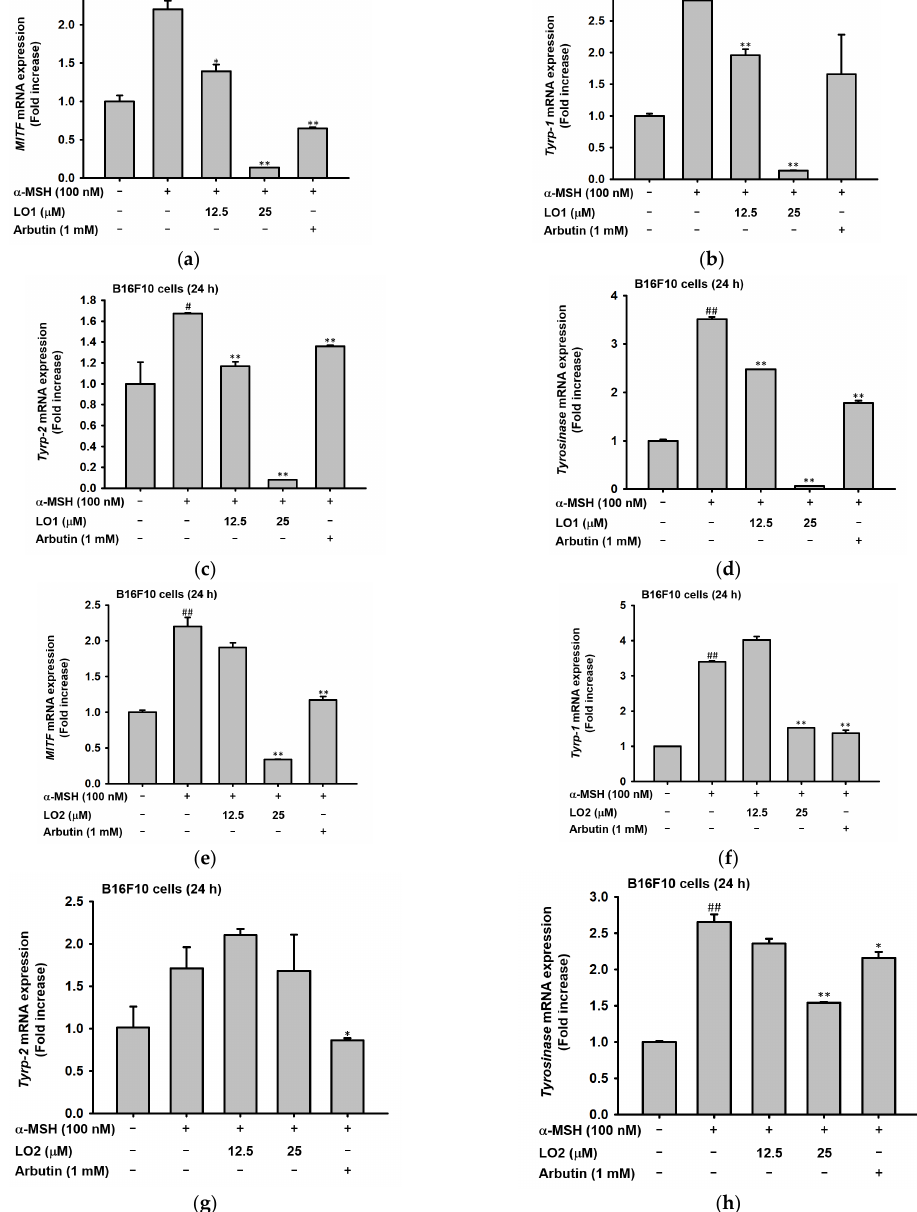
Figure 5. Real-time PCR was conducted to measure mRNA expression after α -MSH treatment ac- companied by LO1 and LO2 treatment for 24 h in B16F10 melanoma cells. Expression of MITF mRNA level in LO1-treated condition in B16F10 melanoma cells. ( a ) The mRNA level of TYRP-1 with or without α -MSH. ( b ) The TYRP-2 expression at the transcription level when treated with LO1. ( c ) Tyrosinase expression was detected in a Real-time PCR assay in treating LO1. ( d ) MITF mRNA level when LO2 treated in B16F10 melanoma cells. ( e ) The expression level of TYRP-1 at the mRNA level. ( f ) The mRNA expression of TYRP-2 presence of α -MSH in B16F10 melanoma cells. ( g ) The expression of Tyrosinase in B16F10 melanoma cells cotreated with α -MSH and LO2. ( h ) Values represent the mean ± standard deviation (SD) of three independent experiments. # p < 0.05 and ## p < 0.01 compared with normal via Mann-Whitney U test. * p < 0.05 and ** p < 0.01, compared with α -MSH-treated group via Mann-Whitney U test. 2.6. Proteins Associated with Melanin Synthesis Decreased Following Western blotting was conducted with B16F10 cell lysates that were treated with α - MSH for confirming the protein levels of upstream molecules to MITF. The protein ex- pression of MITF demonstrated the same pattern with real-time PCR results. The levels of MITF were significantly decreased when LO1 was treated (Figure 6a). Following these